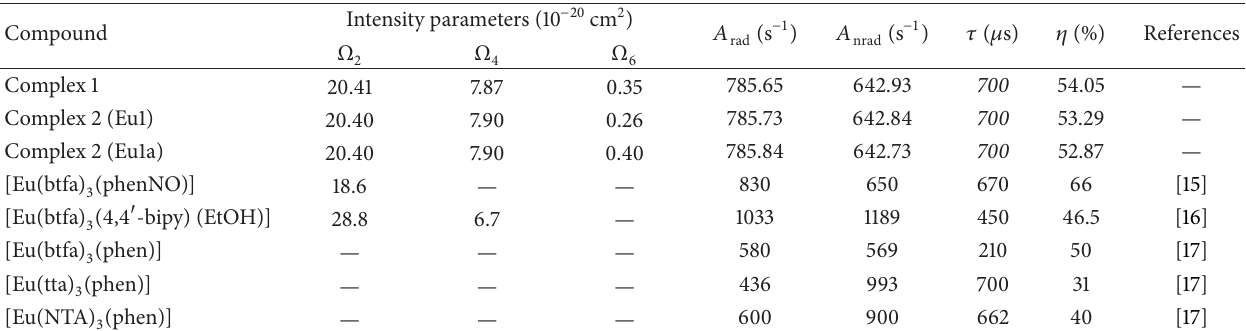
Table 5: Comparison of theoretical (for complex 1 and complex 2) and experimental values (for similar Eu 3+ complexes reported in the ) and nonradiative ( 𝐴 ) emission rates, and quantum yields ( 𝜂 ). literature) of the intensity parameters ( Ω 𝜆 ), radiative ( 𝐴 rad nrad Intensity parameters (10 −20 cm 2 ) Compound